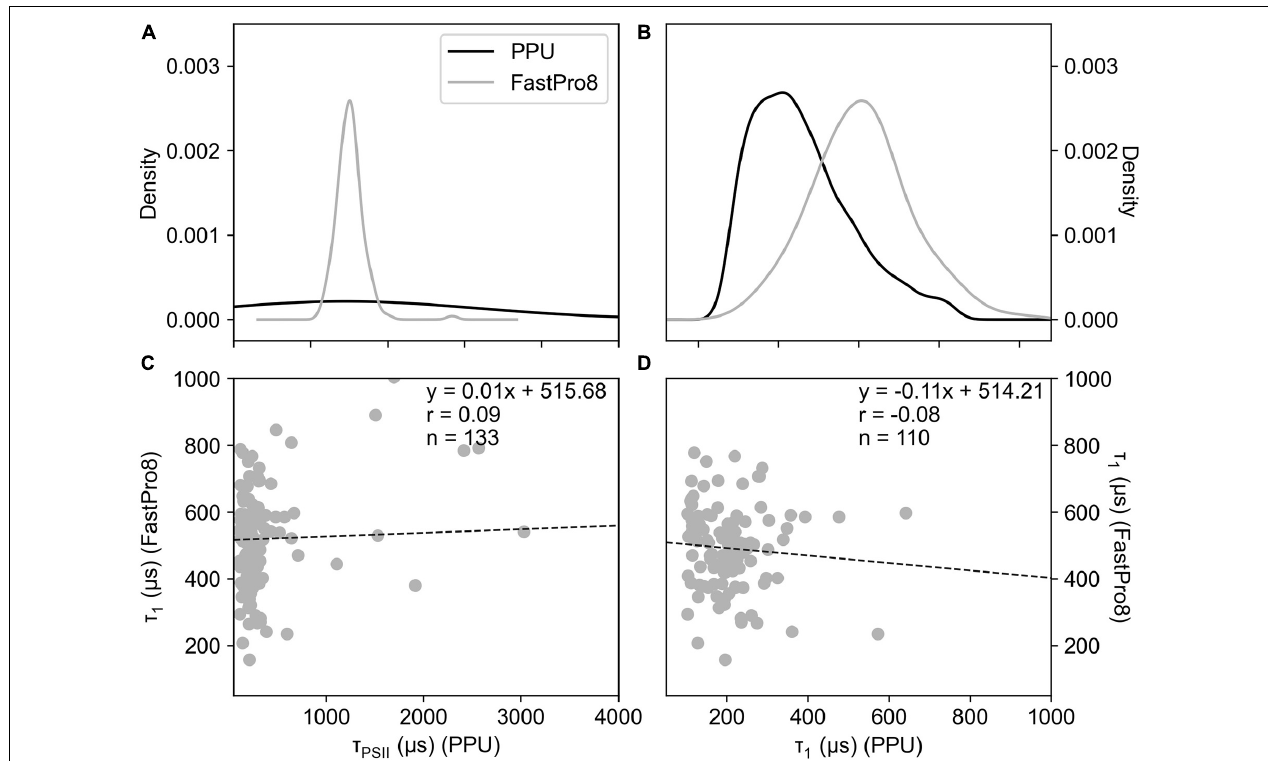
FIGURE 6 | Density histograms of τ ( µ s) from the fitted results of FastPro8 τ 1 and PPU using the single decay τ PSII (A,C) and triple decay ( τ 1 ) (B,D) fitting routines using FAST Ocean data from the South Pacific (IN2016_T01). Correlation plots of FastPro8 τ 1 (Y-axis) and PPU (X-axes) using the single decay (C) and triple decay (D) fitting